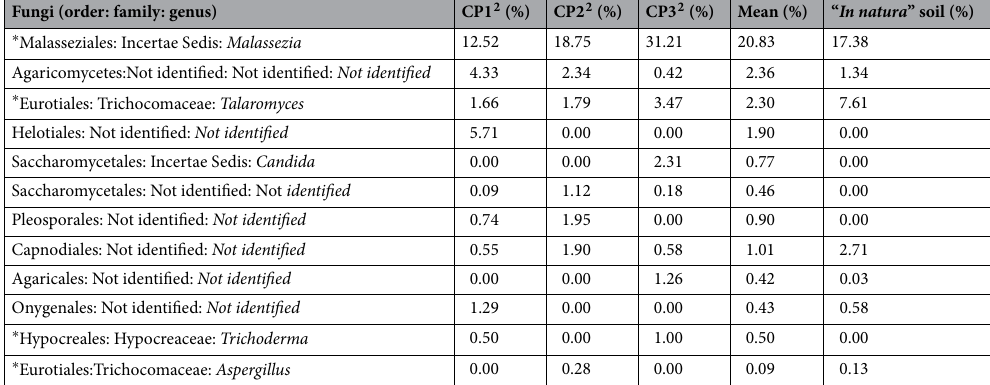
Table 8. Fungi genera